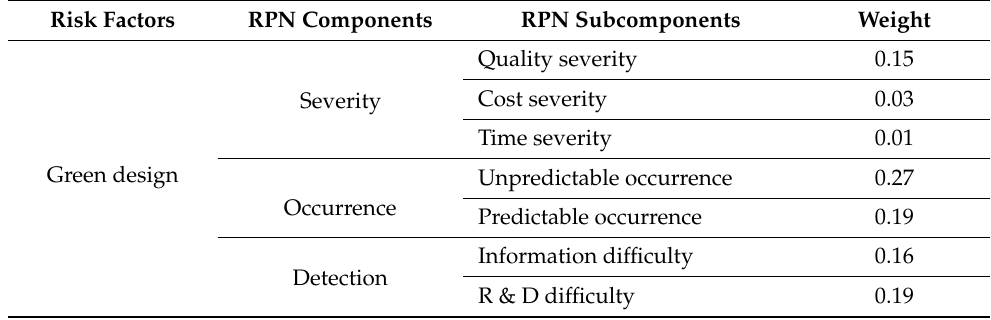
Table 2. The weights for each RPN subcomponent.